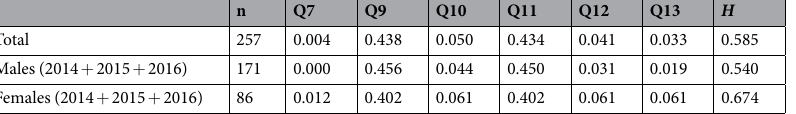
Table 1. Clock gene poly-Q allele frequencies and observed heterozygosity ( H ) of adult Asian short-toed larks in Inner Mongolia,